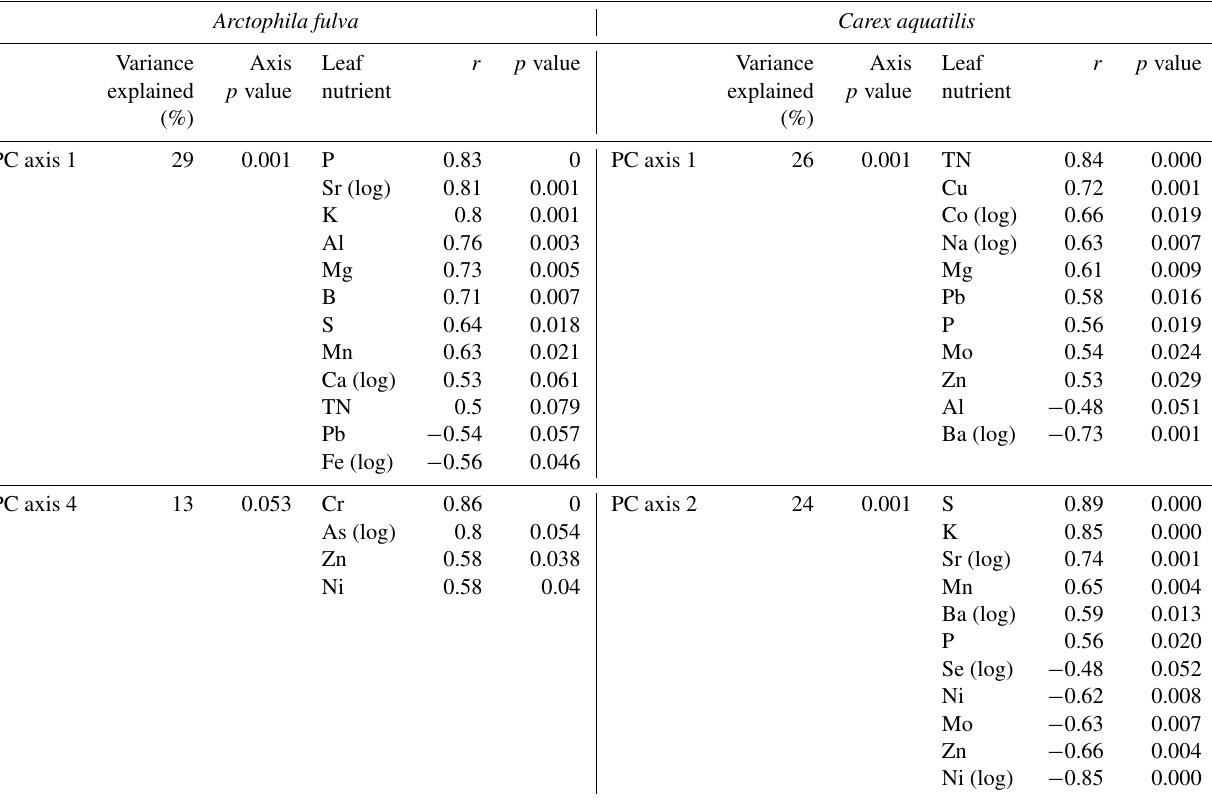
Table 2. Correlation coefficients between PC axes and leaf nutrients for Carex aquatilis (right) and Arctophila fulva (left). Arctophila fulva Carex aquatilis Variance Axis Leaf r p value Variance Axis Leaf r p value explained p value nutrient explained p value nutrient (%) (%) PC axis 1 29 0.001